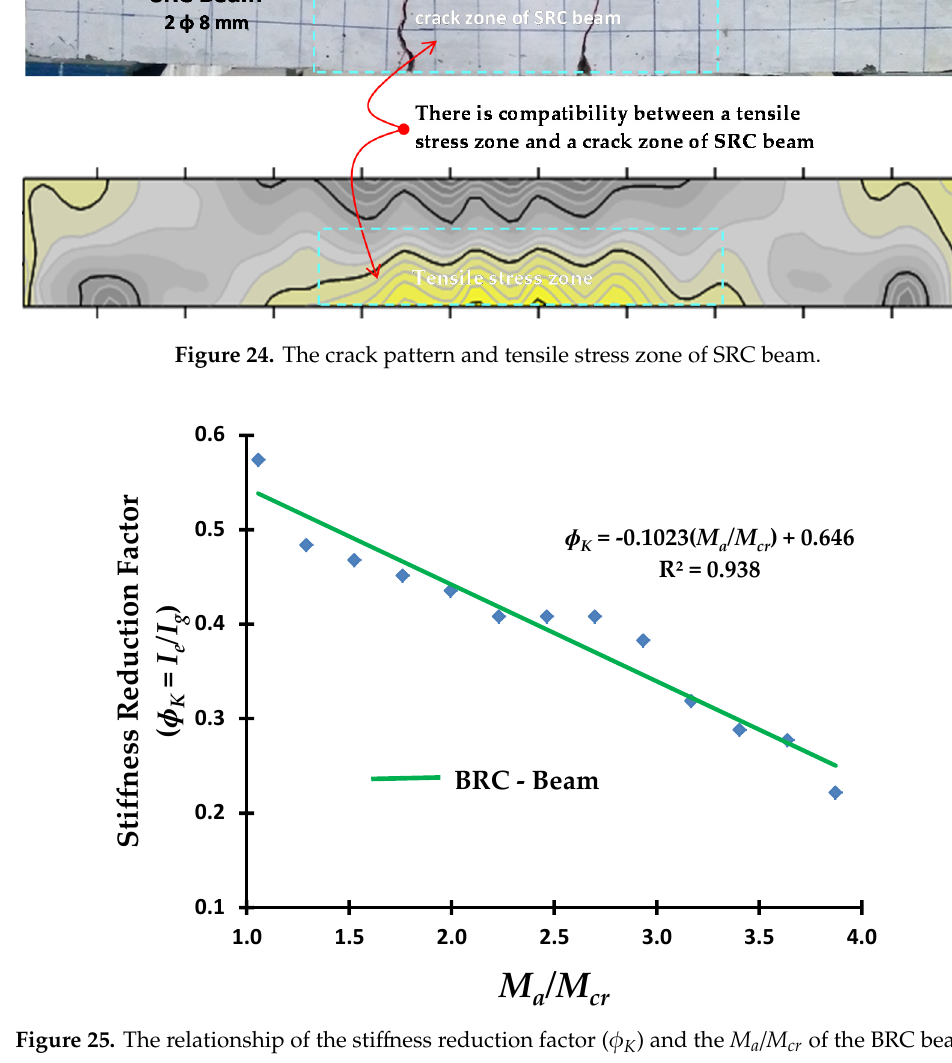
Figure 25. The relationship of the stiffness reduction factor ( ɸ K ) and the M a / M cr of the BRC beam.